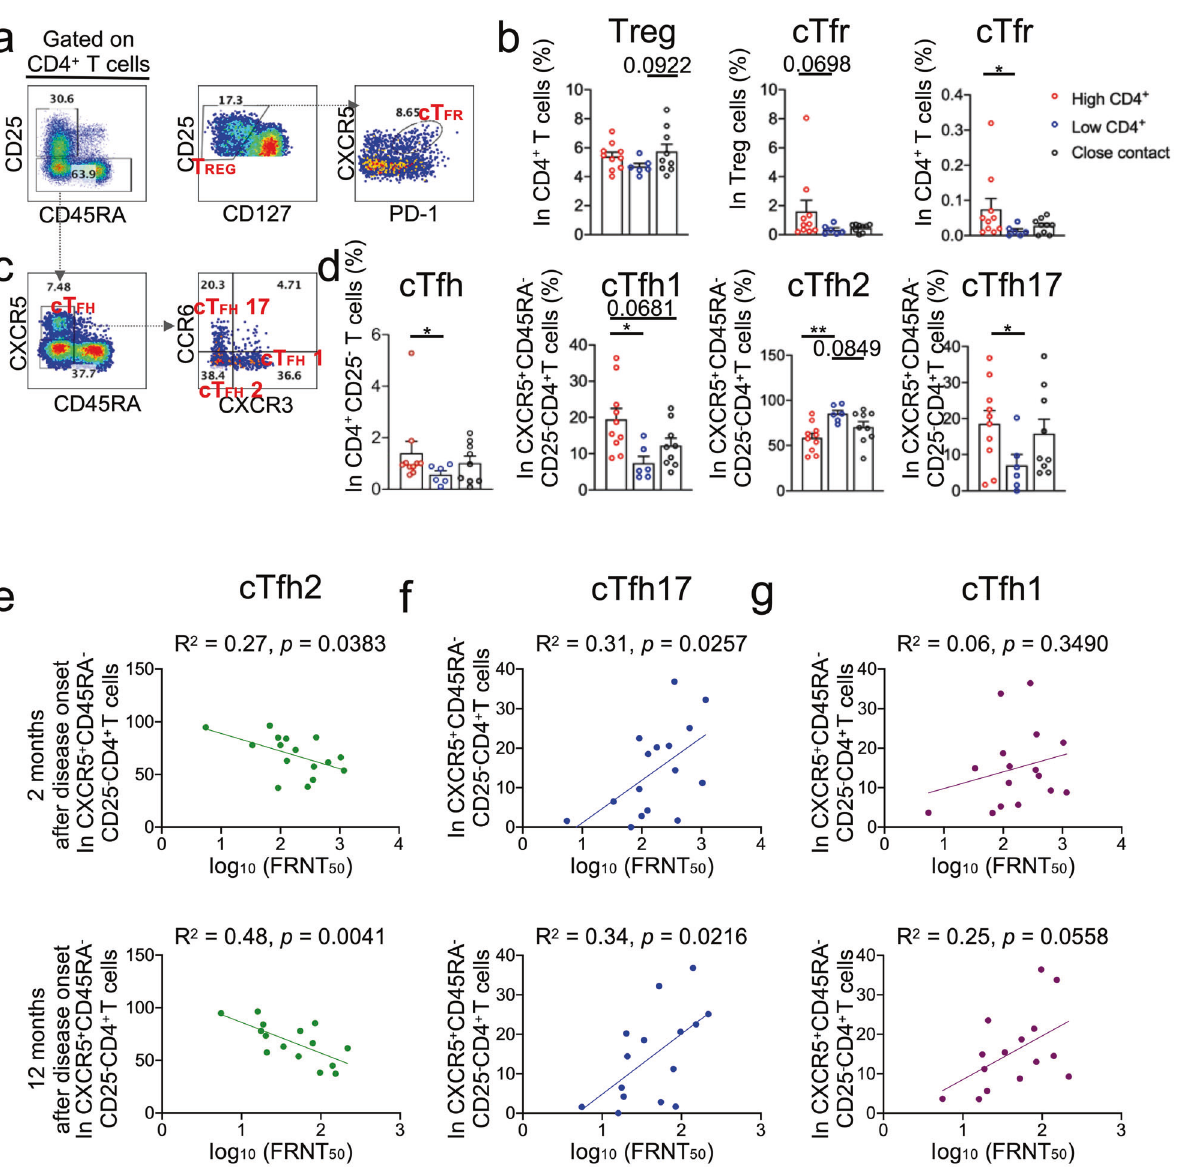
Fig. 5 Peripheral CD4 + T-cell subsets in convalescent patients with COVID-19. T-cell subsets were analyzed by fl uorescence-activated cell sorting (FACS) in peripheral blood mononuclear cell (PBMCs) from high- ( n = 10) and low-CD4 + ( n = 6) convalescent individuals with COVID- 19 and close contacts ( n = 9). a Gating strategies for Treg cells (CD25 + CD45RA − CD127 − ) and cTfr cells (CD25 + CD45RA – CD127 – CXCR5 hi PD-1 hi ). b Dot plot analysis of the frequencies of Treg and cTfr cells in high- and low-CD4 + convalescent individuals with COVID-19 and close contacts. c Gating strategies for different peripheral circulating Tfh cell subsets, including CXCR3 + CCR6 − cTfh (cTfh1) cells, CXCR3 – CCR6 – cTfh (cTfh2) cells, and CXCR3 – CCR6 + cTfh (cTfh17) cells. d Frequencies of cTfh1, cTfh2, and cTfh17 cells in high-and low-CD4 + COVID-19 convalescent individuals with COVID-19 and close contacts. e – g Correlation analysis of ( e ) cTfh2, ( f ) cTfh17, and ( g ) cTfh1 cells with SARS-CoV-2-speci fi c neutralizing-antibody titers in high-and-low-CD4 + convalescent individuals with COVID-19 ( n = 16). Each dot represents an individual participant. Bars represent mean values. * p < 0.05 and ** p < 0.01. Student ’ s t -test was used to analyze differences in the mean values between groups. The Mann – Whitney test was used to compare the central tendencies of the two groups (mean or median). Data are presented as mean ±